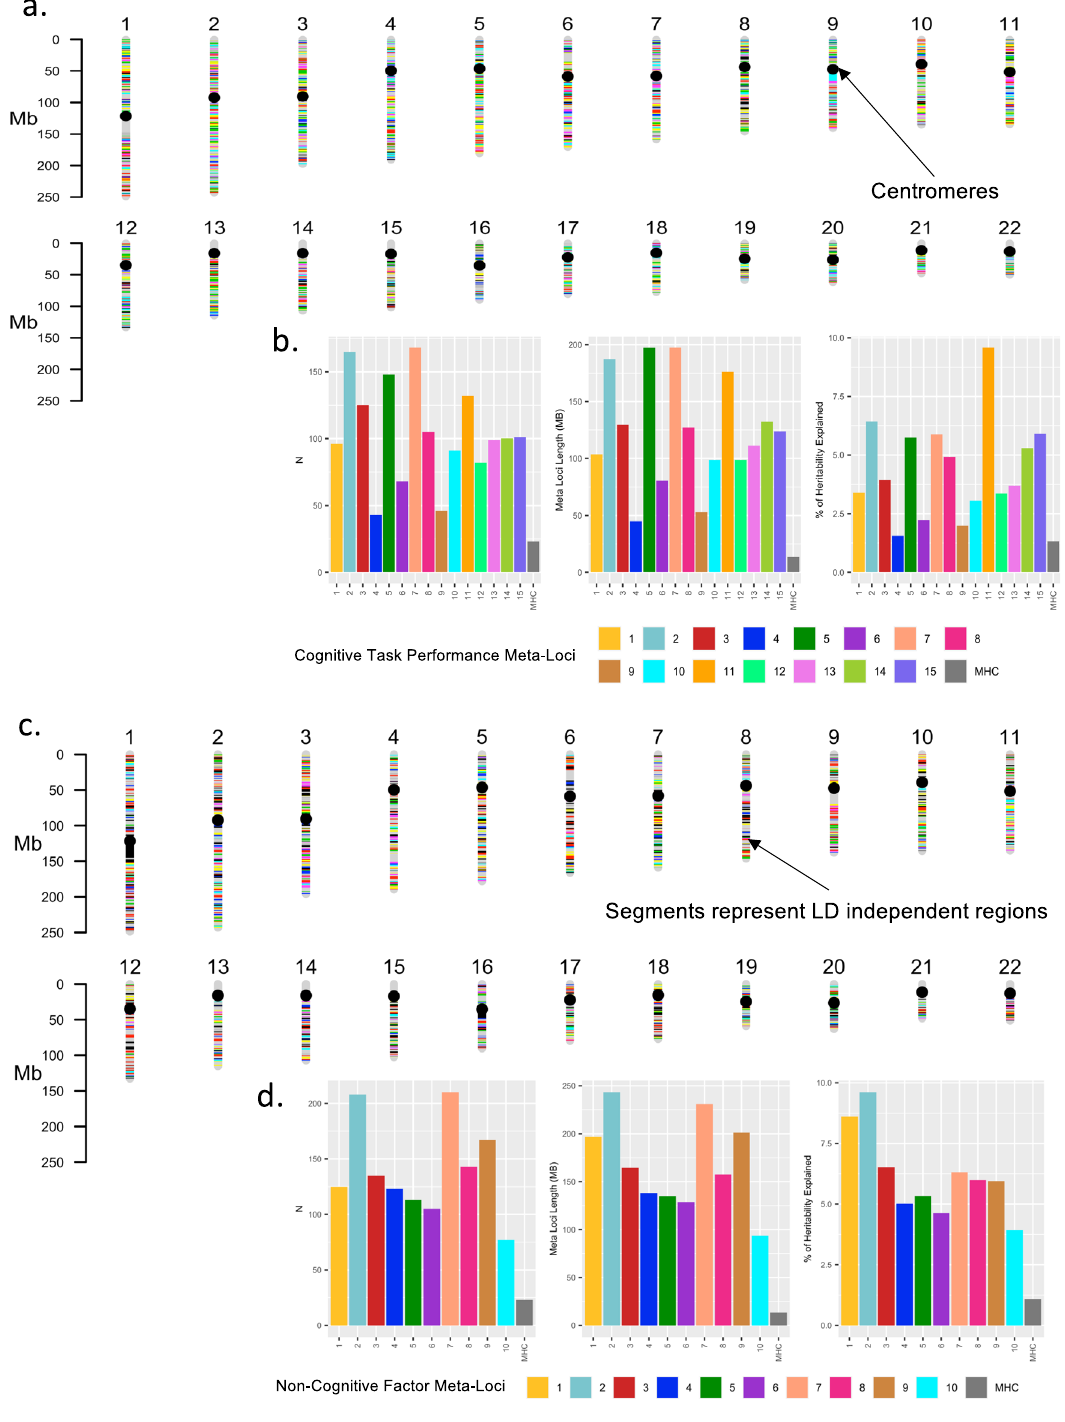
Fig. 2 | Karyotype plots for genomic locations of meta-loci and descriptive statistics for meta-loci. a Karyotype plot for CTP ( b ) number of LD segments, length, and percentage of heritability estimated for each meta-loci for CTP ( c )